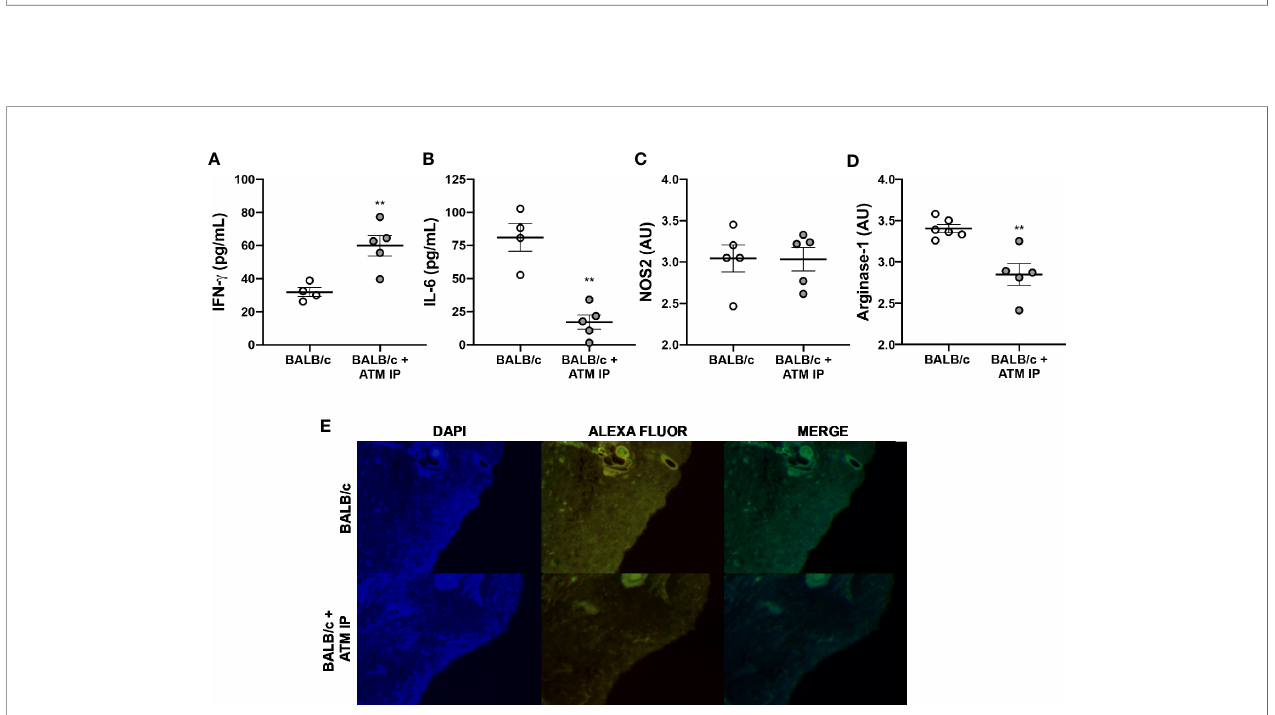
FIGURE 8 | Immunomodulation of ATM mice. Homogenates of L. amazonensis -infected BALB/c and BALB/c that received ATM via intraperitoneal paws were submitted to (A) IFN- g and (B) IL-6 measurement by CBA assay; and (C) Arg-1 and (D) iNOS measurement by ELISA. Data represent the mean ± SEM of fi ve mice groups. ** Signi fi cant difference with the opposite strain infected by L. amazonensis , p ≤ 0.01. (E) Arginase-1 immuno fl uorescence study. Cell nucleus was stained with DAPI and arg-1 was stained with Alexa Fluor. ATM, adoptive transfer of macrophages; AU, arbitrary units; IP,